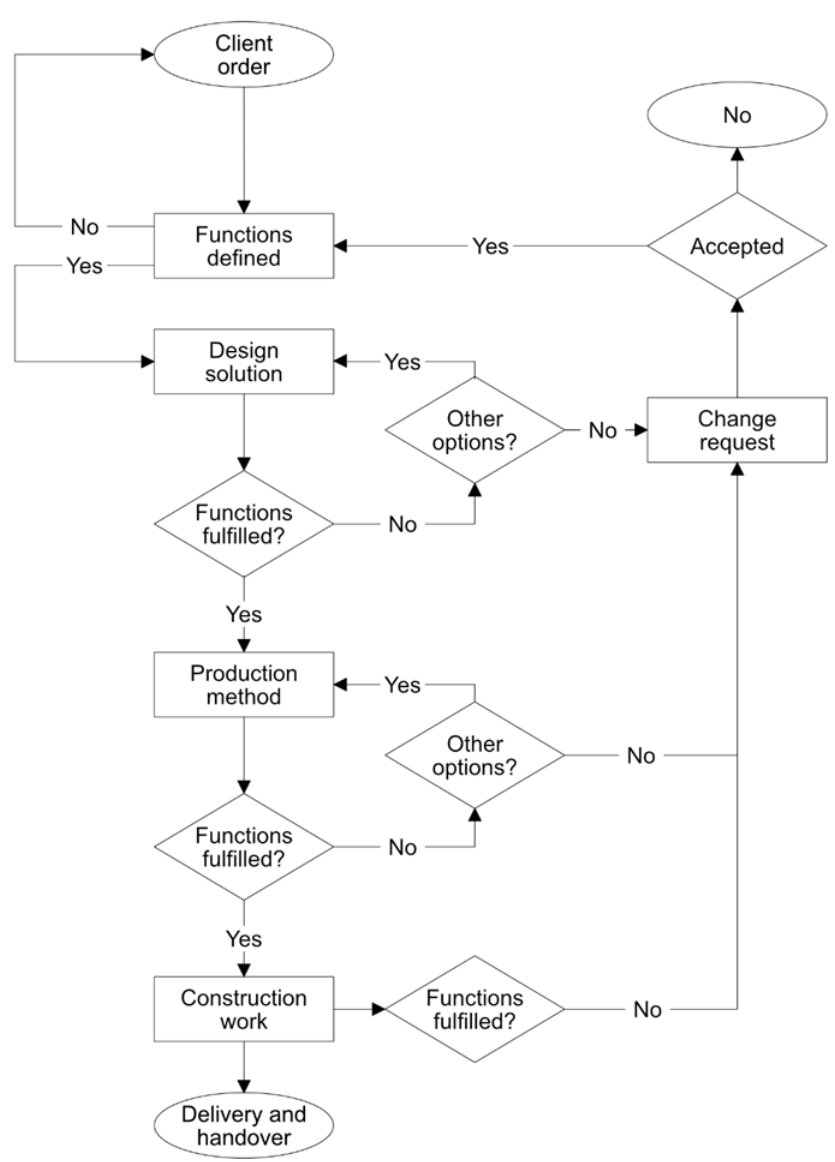
Figure 5. Configuration decision flow chart for construction projects.